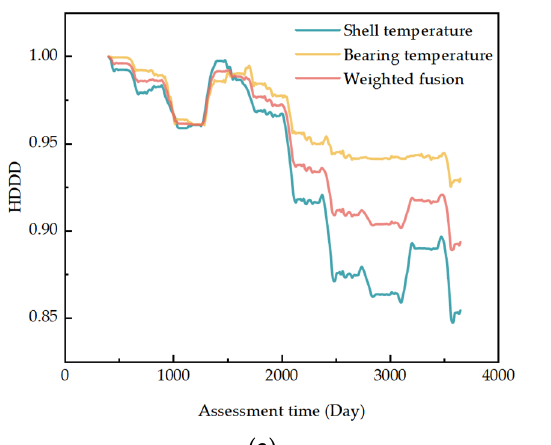
Figure 7. Calculation results of ( a ) the health degree of data distribution deviations (HDDD) and ( b ) the similarity of operational data changes (SOC).